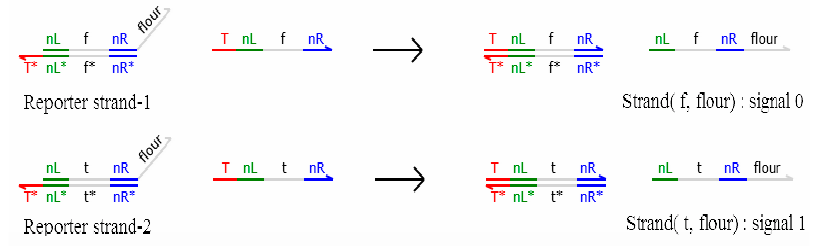
Figure 10. Domain label signal detection reaction.